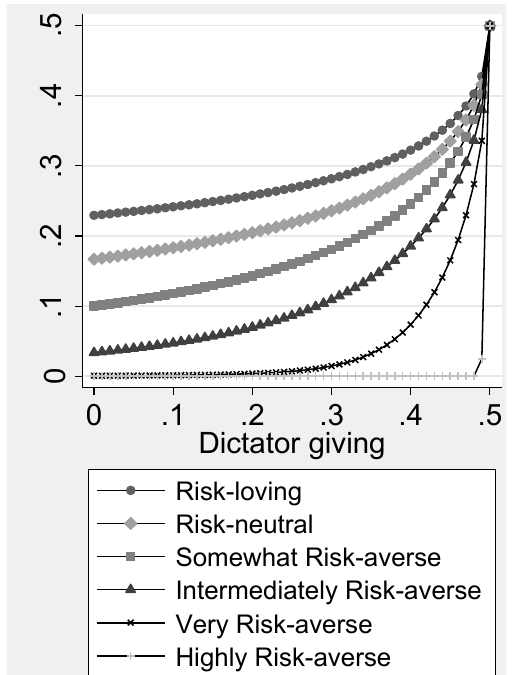
Figure 1. Predictions across games based on the ERC